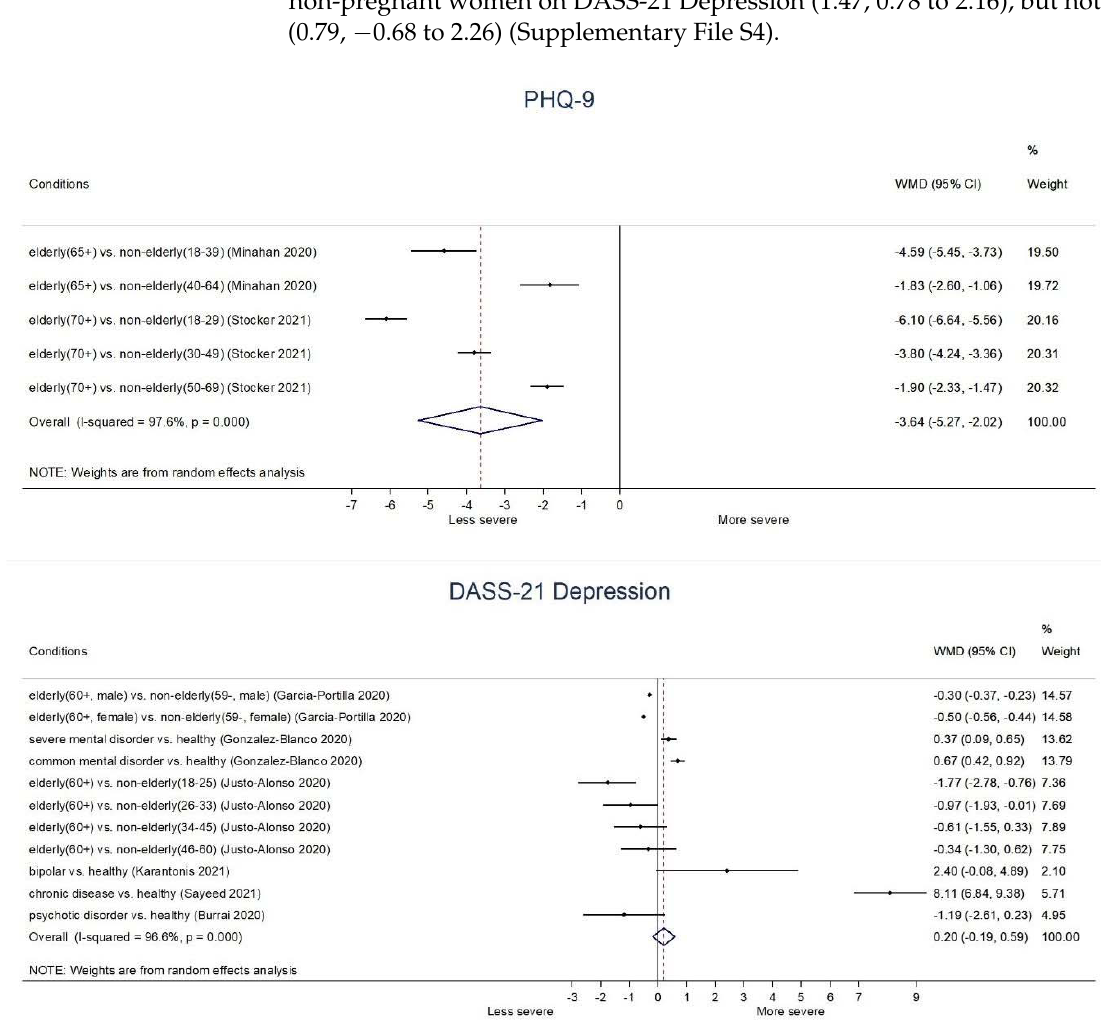
Figure 2. Depressive symptoms in vulnerable groups during COVID-19. Abbreviations . DASS-21, Depression, Anxiety, and Stress Scale-21; PHQ-9, Patient Health Questionnaire.